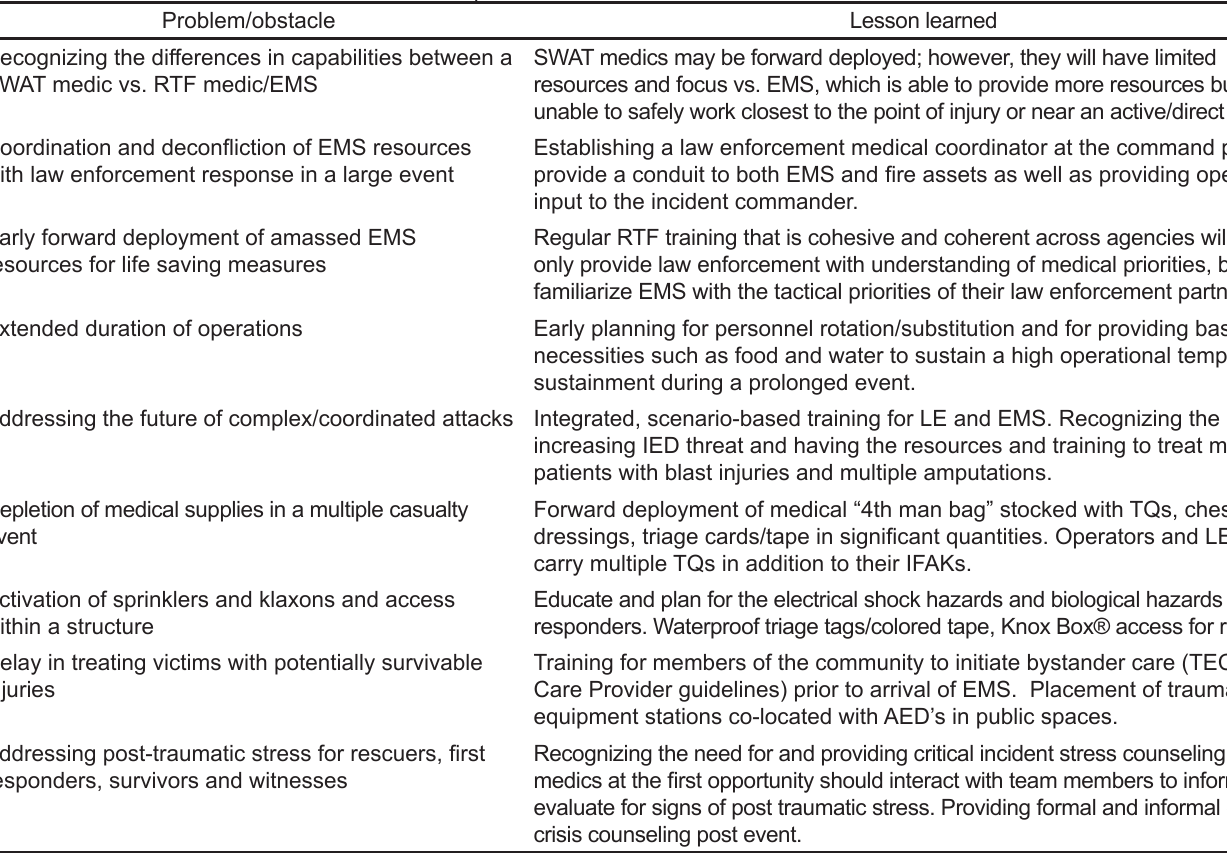
Table. A visual correlation of lessons learned with problems encountered on December 2,